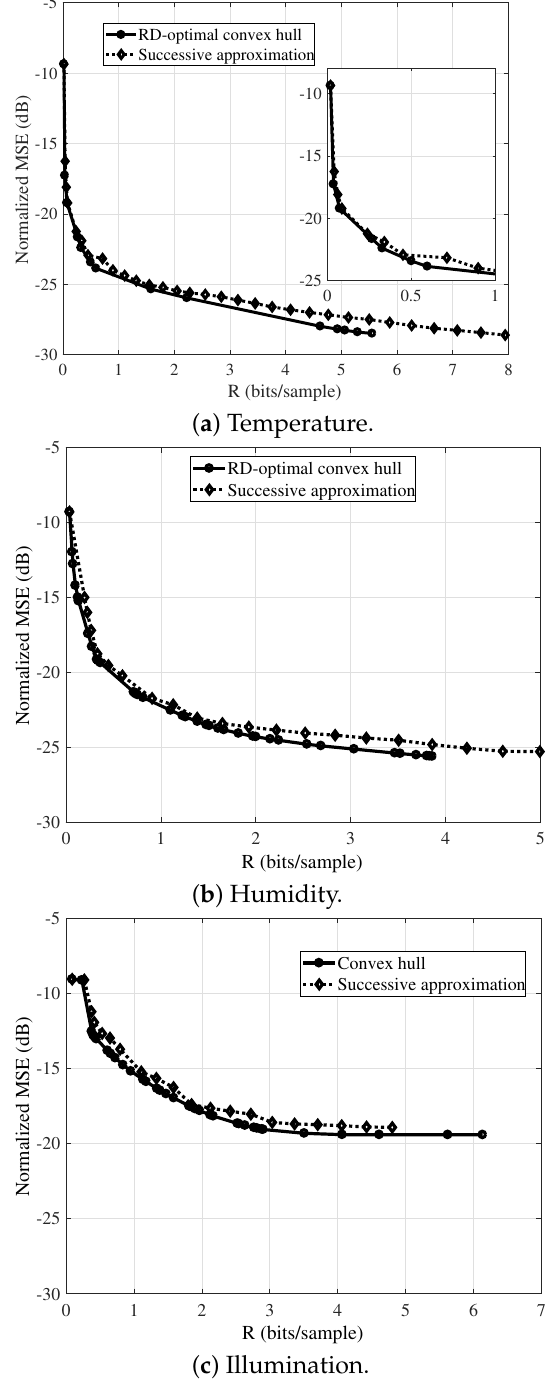
Figure 8. RD-optimal convex hull and rate-distortion curves for the successive approximation scheme, for the reconstruction of the signals with LASSO. The block length N is equal to